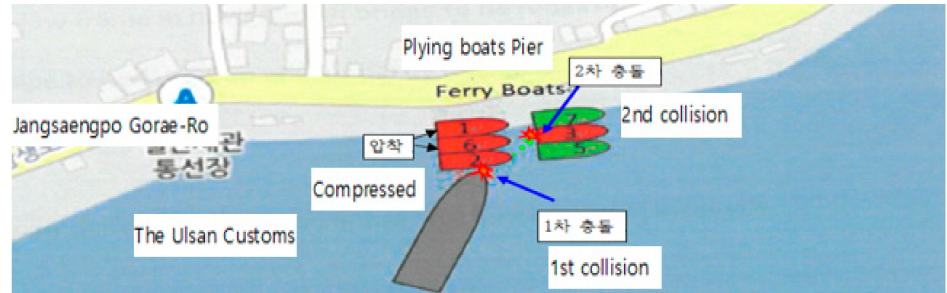
Figure A2. Diagram of the collision